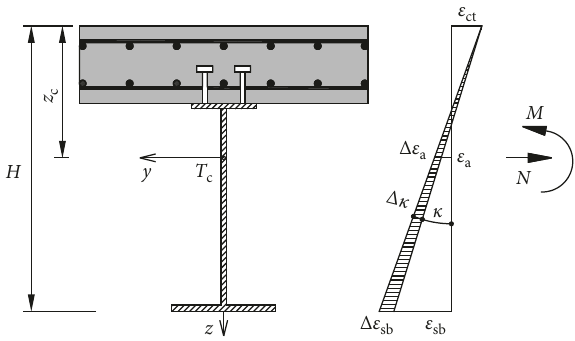
Figure 5: Strain distribution and its correction during iterations.